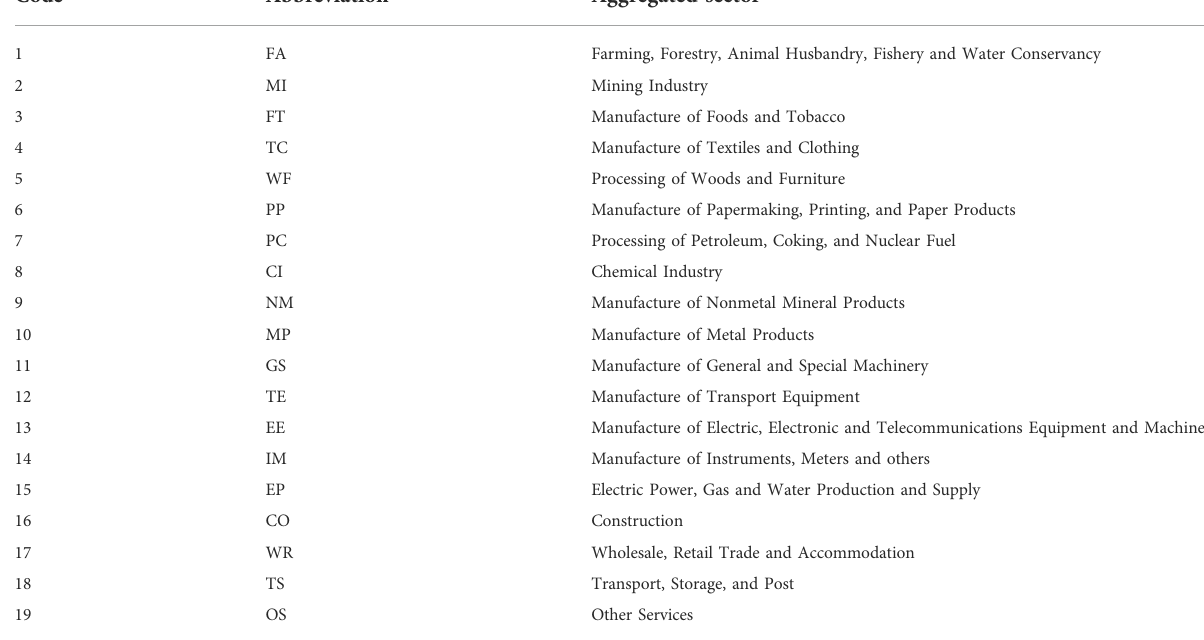
TABLE 1 The 19 aggregated sectors and the corresponding